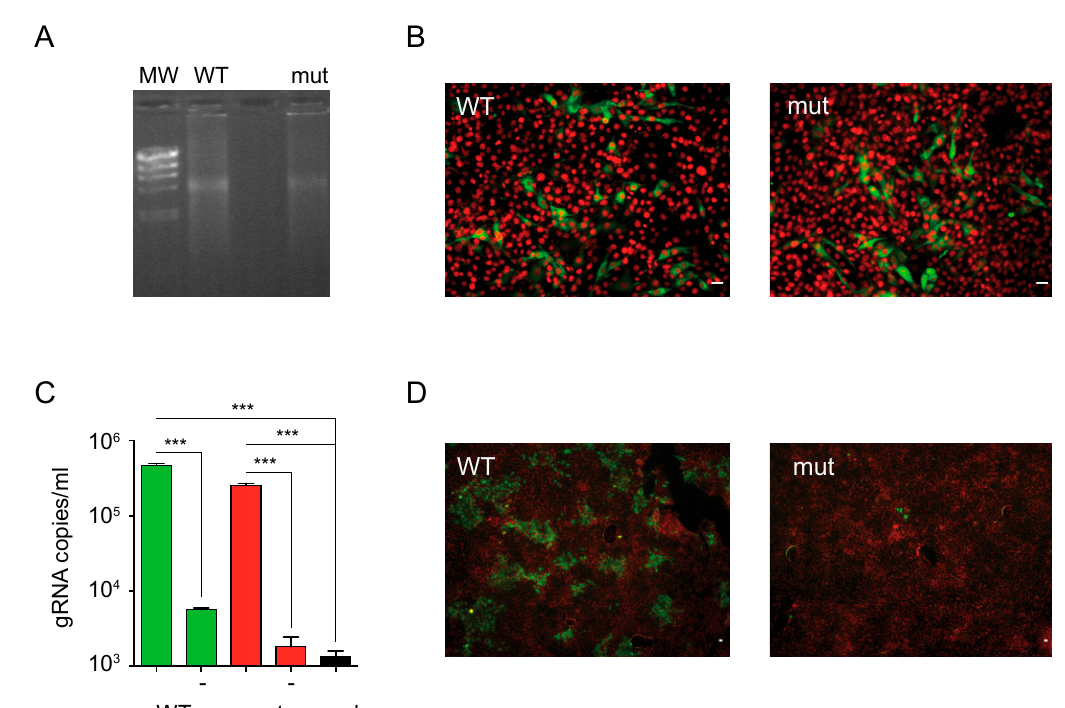
Figure 4. BVDV particles bearing mutations in the exposed β -hairpin motif display reduced infectivity. ( A ) Agarose gel electrophoresis of in vitro transcribed genomic RNAs of wild type (WT) and mutant (mut) ncpBVDV. Lambda DNA/HindIII marker (MW) was used as a reference. ( B ) E2 expression in cells transfected with wild type and mutant RNAs. Representative fluorescence microscopy images acquired with 20 × objective of MDBK cells transfected with wild type (WT) or mutant (mut) RNAs and stained with a polyclonal antibody against E2 (green channel) and DAPI (red channel). Scale bar: 10 µ m. ( C ) BVDV virion production to the supernatant of transfected cells. Bar graph for the titers of wild type and mutant viruses produced to the supernatant of transfected cells estimated by qPCR. No reverse transcriptase controls are indicated with (-). The black bar represents a control for mock transfected cells. Error bars represent the standard deviation of triplicate points. Data were analyzed by one-way ANOVA with Bonferroni’s posttest (***, p < 0.001). ( D ) Infectivity of wild type and mutant BVDV virions. Representative fluorescence microscopy images acquired with 4 × objective of MDBK cells infected with wild type (WT) or mutant (mut) BVDVs recovered from transfected cells and stained with a polyclonal antibody against E2 (green channel) and DAPI (red channel). Scale bar: 10 µ m. The results are representative of at least three independent